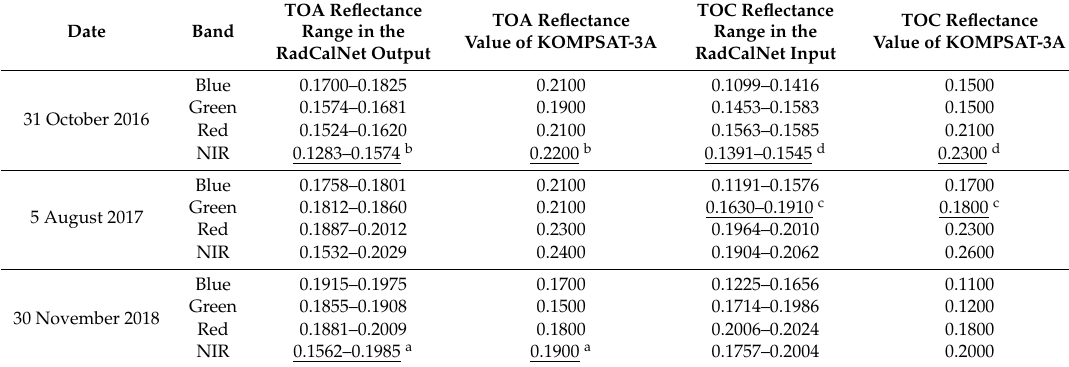
Figure 3. Comparison between the RadCalNet BTCN data and the KOMPSAT-3A reflectance product: ( a ) TOA and ( b ) TOC reflectance products for 31 October 2016, 5 August 2017, and 30 November 2018. Table 2. KOMPSAT-3A TOA and TOC reflectance products and RadCalNet BTCN data for 31 October